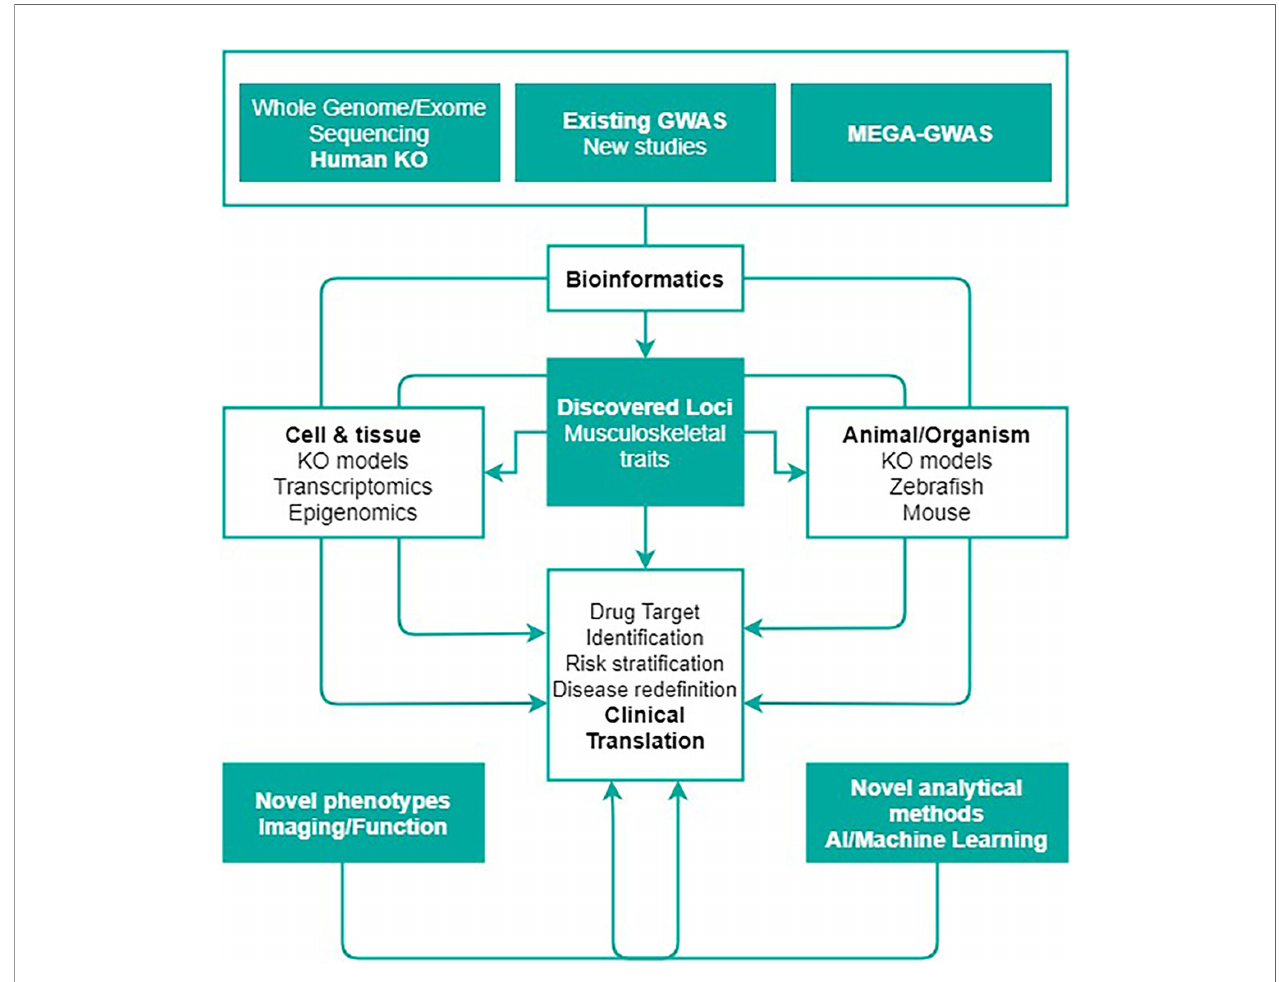
FIGURE 1 | The abundance of genetic discoveries needs the creation of a roadmap seeking to organize the functional assessment of genes and biological pathways underlying musculoskeletal metabolism, ultimately highlighting the opportunities to translate these discoveries into clinical applications. This fi gure shows the rationale behind GEMSTONE scienti fi c objective to translate current and future genetic fi ndings in the clinic. Figure adapted with permission from Kiel et al.